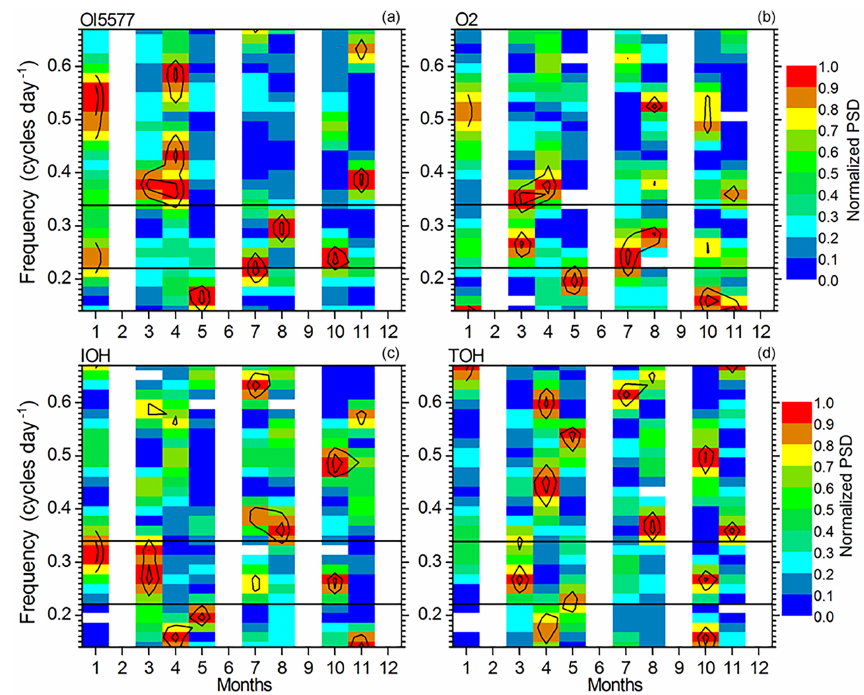
Figure 2. Monthly normalized Lomb–Scargle periodogram of OI5577 (a) , O2b(0-1) (b) and OH(6-2) (c) emissions as well as OH (d) temperature. Horizontal black lines delimit the period range from 3 to 4 days and contoured black lines identify peaks in the periodogram.